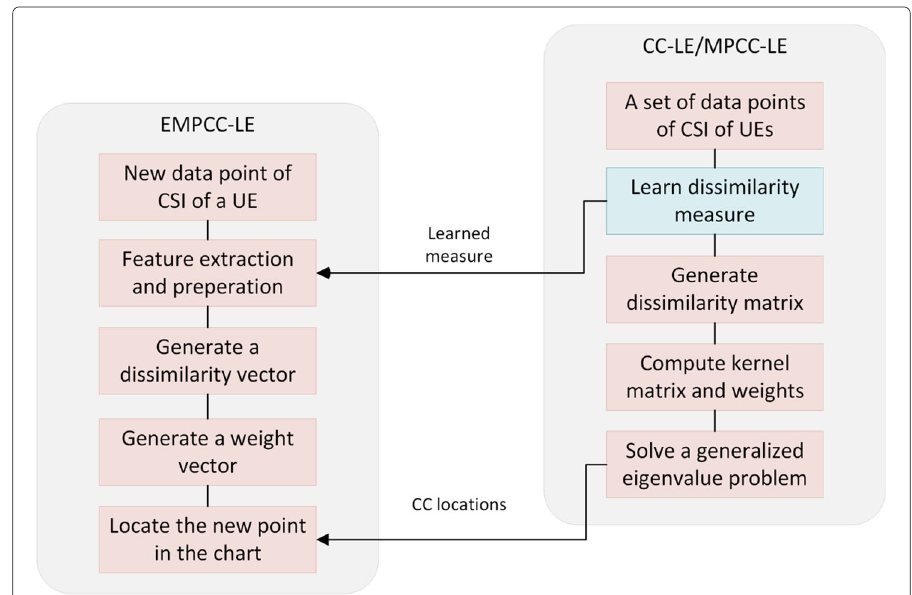
Fig. 3 Main steps of MPCC and EMPCC. EMPCC uses the CC locations of the offline training set and the dissimilarity measure learned by MPCC